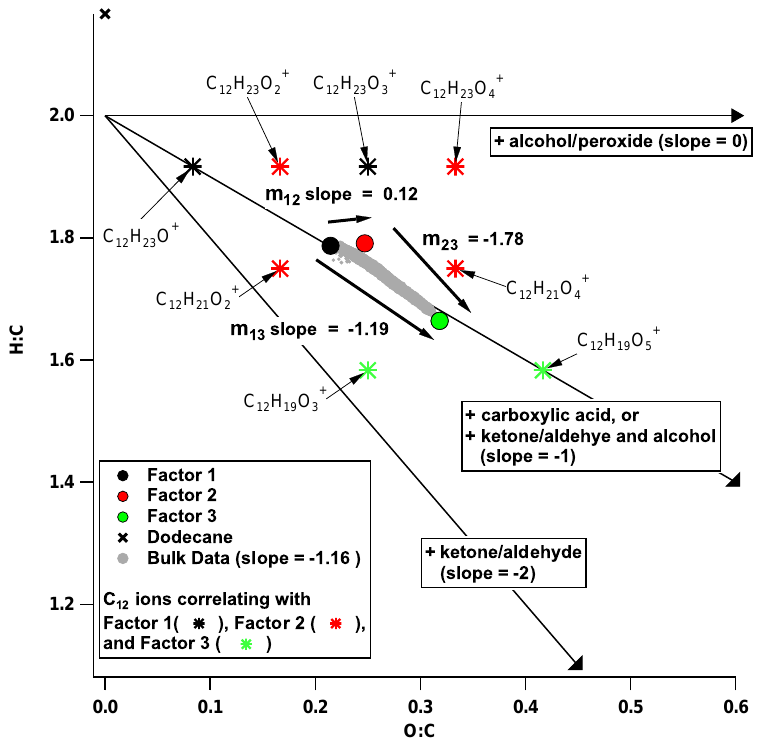
Fig. 15. Van Krevelen diagram for low-NO x photooxidation of dodecane. HR-ToF-AMS bulk composition data are indicated by the grey markers and PMF factors 1–3 are shown by the black, red, and green circle markers. C 12 ions, which are the ions retaining the most molecular-level detail, with high correlation to each factor are also displayed by the black, red, and green star